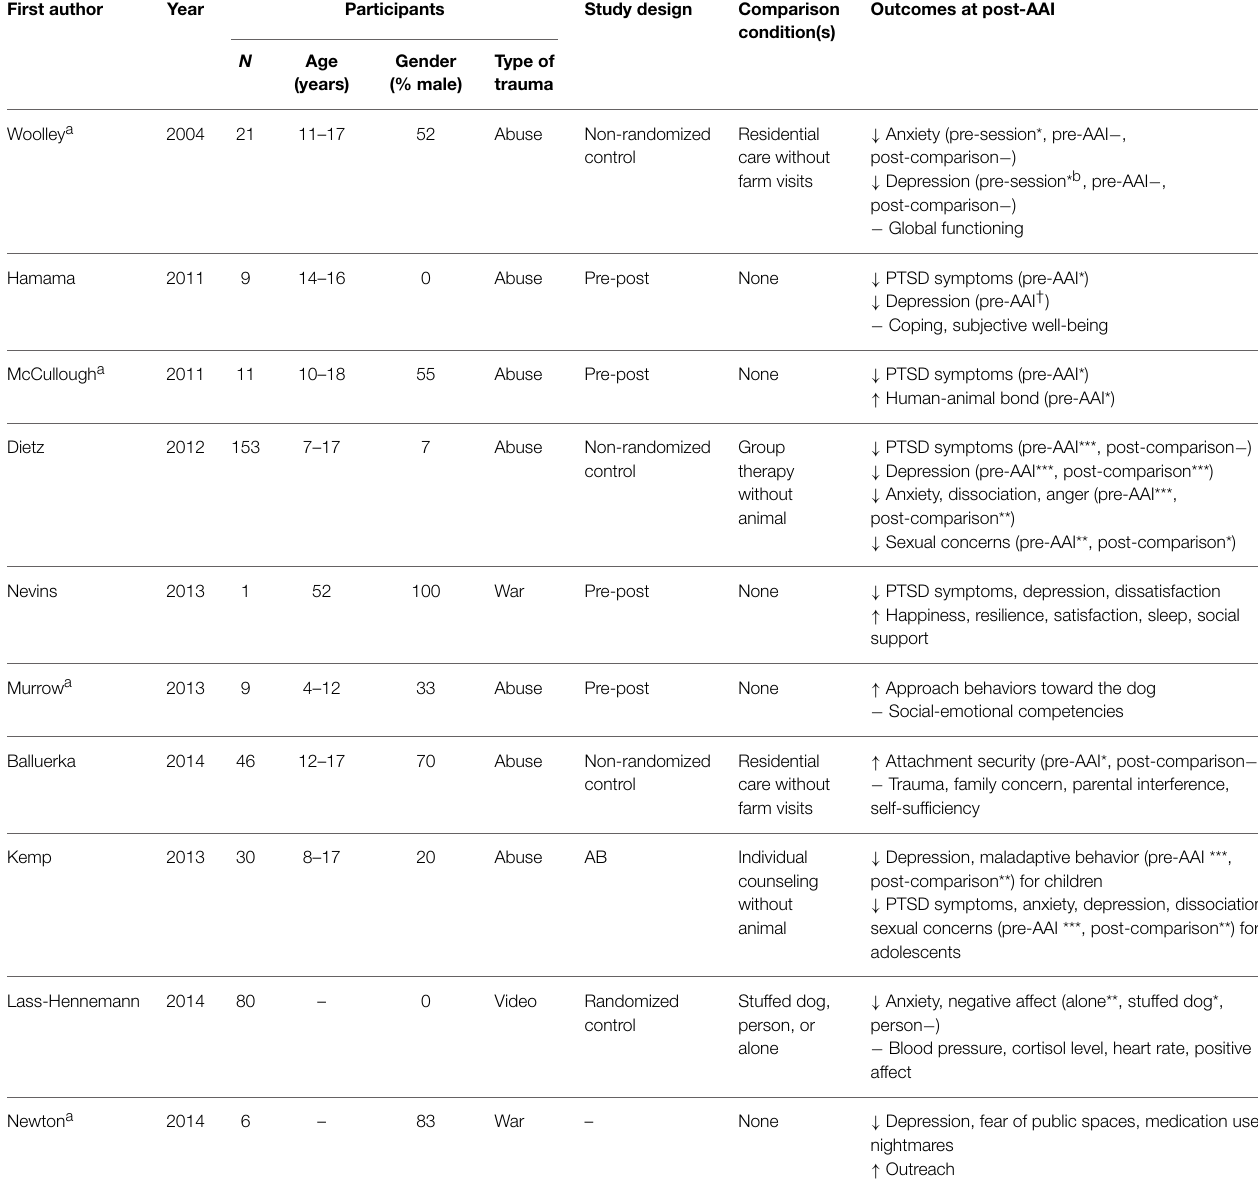
TABLE 3 | Summary of participants, study design, and